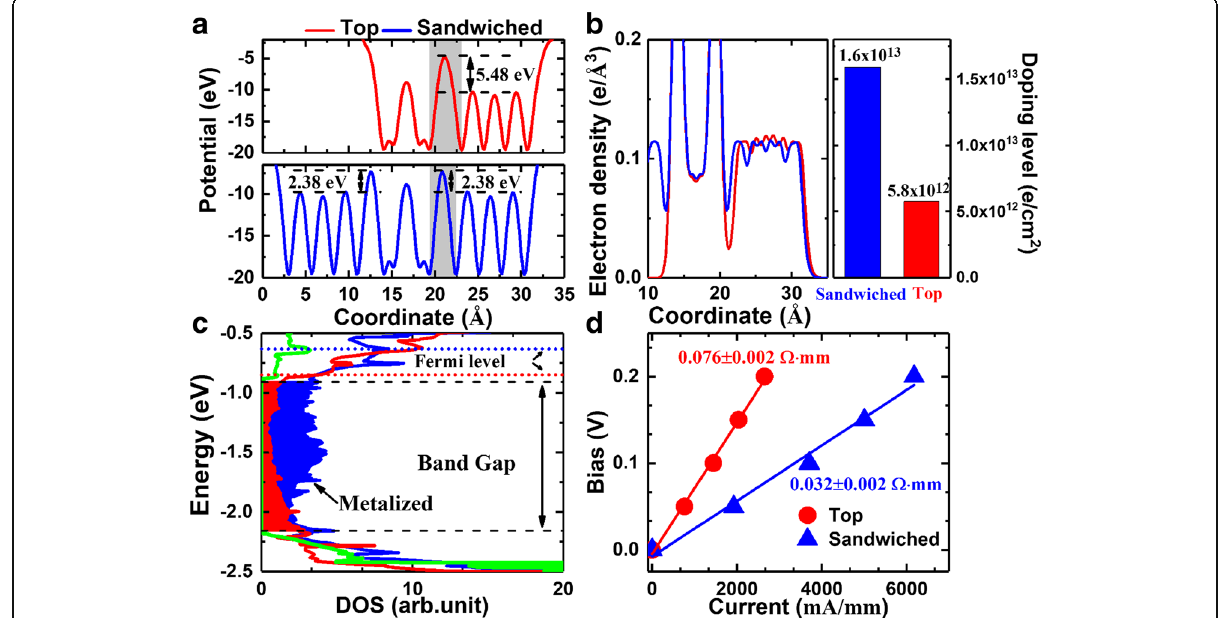
Fig. 4 a Effective potential normal to the transport direction. The coordinate corresponds to the location of atoms and is defined in Fig. 1. The dark regions correspond to the vdW gap. b Plane-averaged electron distribution normal to the transport direction. The right panel is the doping level. The coordinate corresponds to the location of atoms and is defined in Fig. 1. c DOS of InSe. The green corresponds to pristine InSe. d Current dependent bias of the two probe devices. All of the red and blue correspond to top and sandwiched contacts,